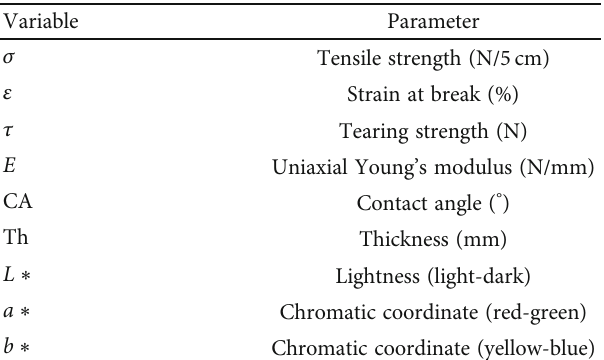
Figure 4: Force-displacement curve of the tearing test. Table 2: Designation of